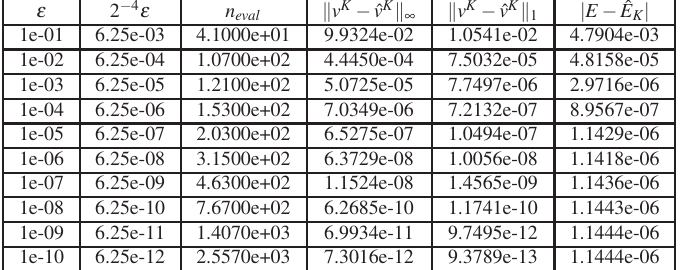
Table 12 Parameters as specified in Table 1 for f 2 , K = 15 and the cubic rule. ε k = ε varies between 10 − 1 and 10 − 10 .